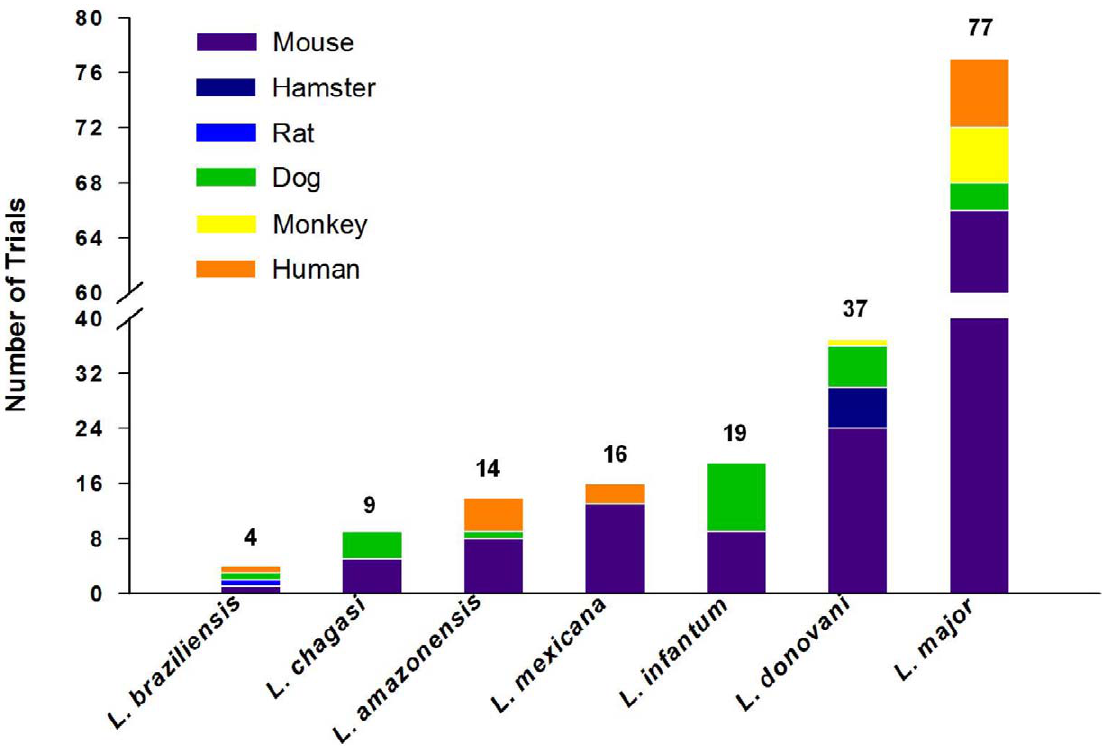
Figure 3. Animal models used in leishmaniasis trials. Data are derived from Table S1, which contains a summary of all vaccines to date (both experimental and in clinical use). Each color code reports the hosts in which Leishmania vaccines have been tested.